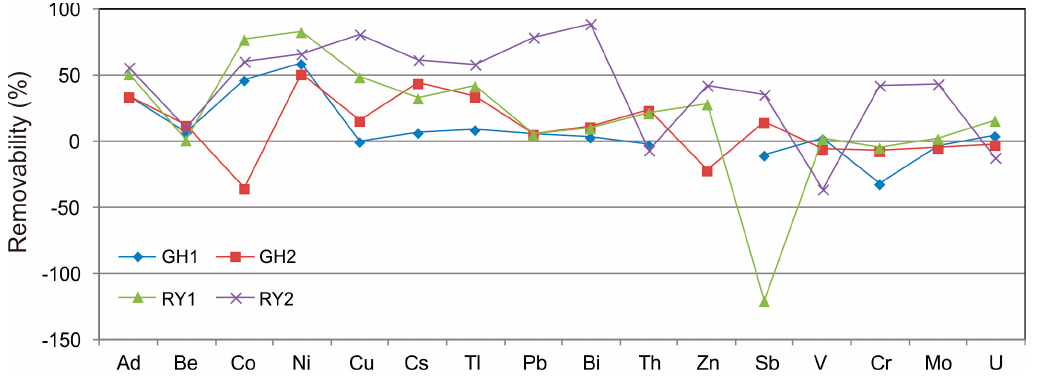
Figure 9. The removability of toxic elements in cleaned coal.